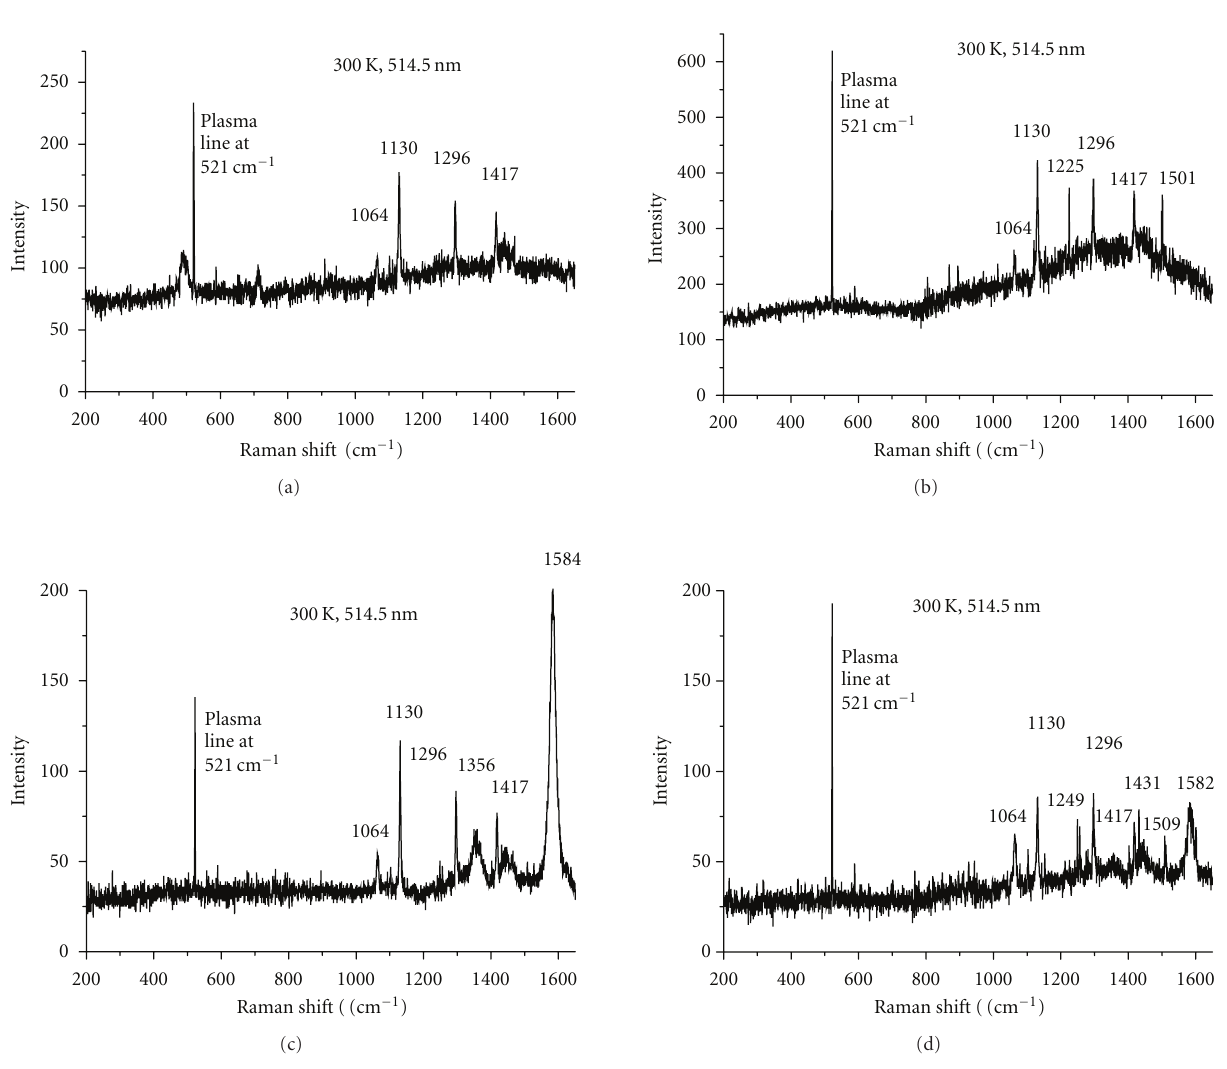
Figure 7: Raman spectrums of (a) neat UHMWPE, (b) UHMWPE after strain hardening, (c) UHMWPE-MWCNT, and (d) UHMWPE- MWCNT after strain